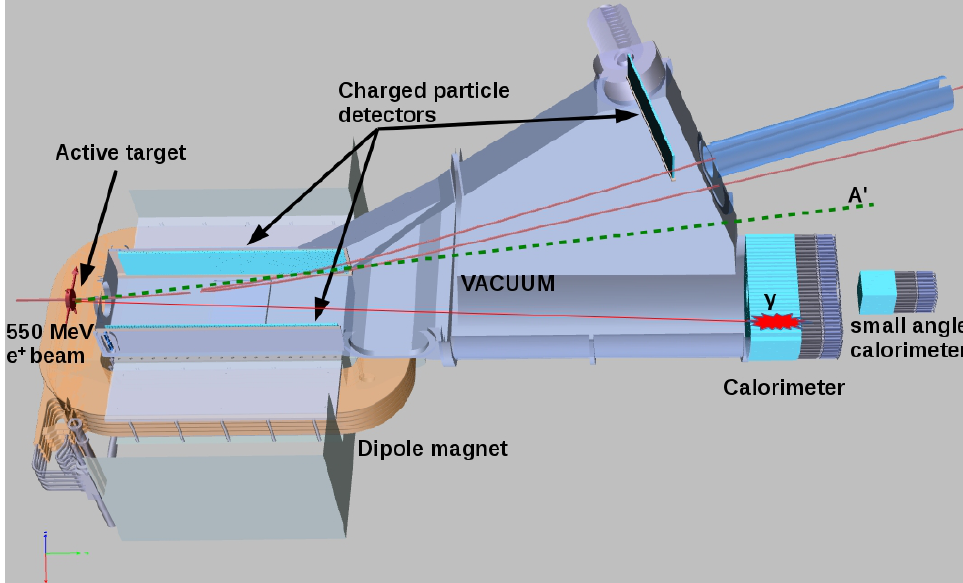
Figure 1. Outline of the PADME